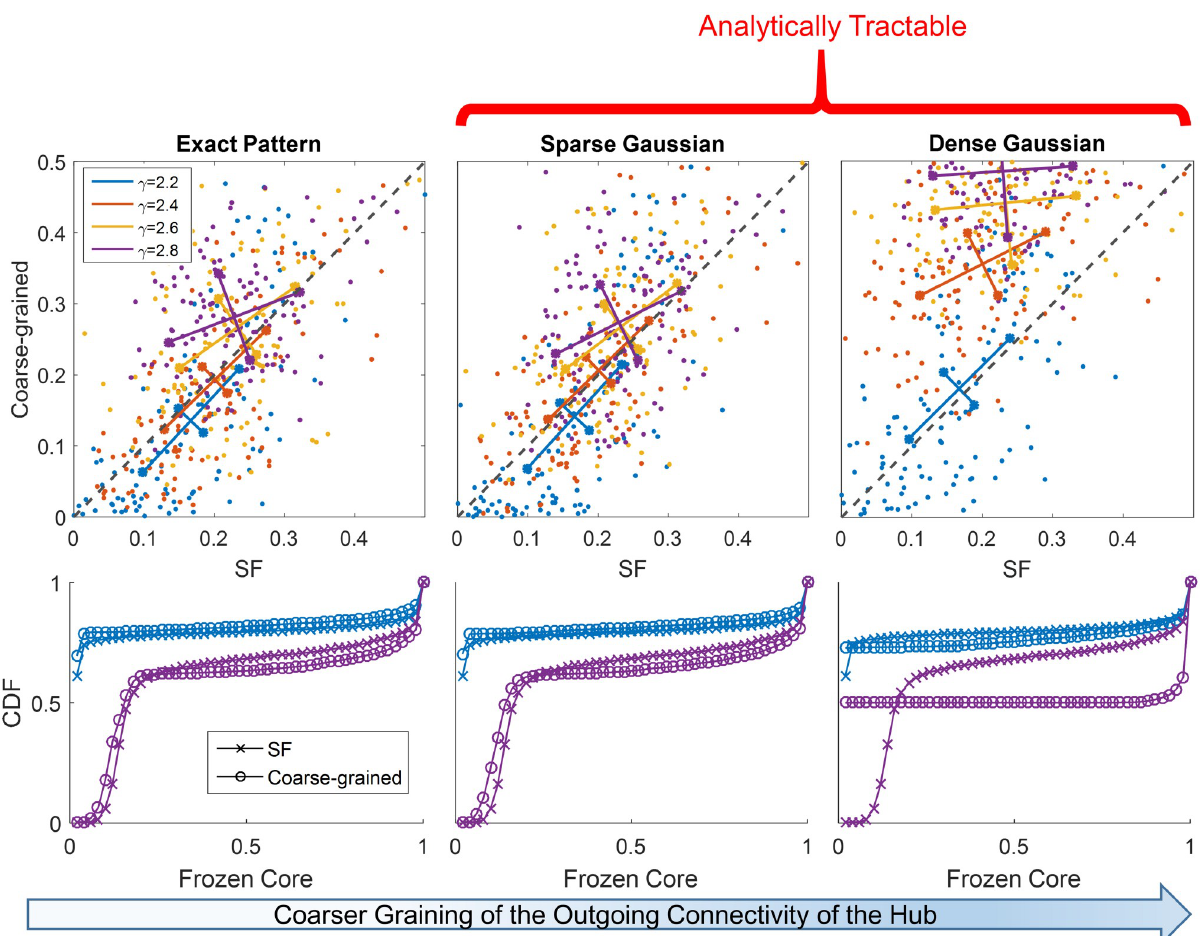
Fig 4. Lumped-hub approximation captures SFO network properties for a range of power-laws. Within the lumped-hub approximation, we show three coarse grained versions of the hub outgoing connectivity pattern. (Left) Exact pattern of connectivity is maintained. (Middle) Number of nonzero connections is maintained, but their weights are replaced by a Gaussian distribution. (Right) A single Gaussian distribution describes all outgoing connections. (Top) Probability of converging to QFP for SFO networks and their respective lumped-hub approximations with increasingly coarse graining. For each SFO parameter γ (color code and legend), 125 topology realizations T were drawn, and the convergence probability was estimated from 50 realizations of the connection strength J and initial conditions. On each colored cluster of points, longer lines denote the direction of the linear fit to each γ , and the size of the perpendicular segment is the remaining variance after the fit. The identity line is added for reference (dashed black). Data points were jittered by a small uniform random noise (in range of ± 0.01) to avoid their overlap due to discrete sampling. (Bottom) Cumulative distributions of frozen core sizes for SFO networks and their lumped-hub approximations for two power-law exponents: γ = 2.2, 2.8 (color coded as in the top panels). All scale free distributions have k = 1 (see Materials and methods for more min